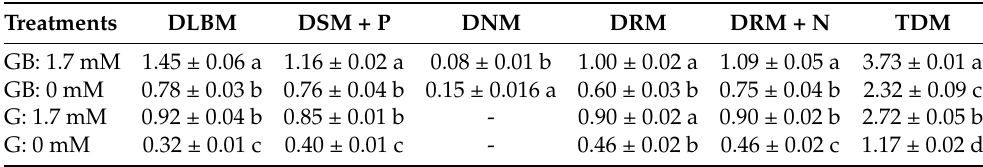
Table 2. Production of dry leaf blade mass (DLBM), stem + petiole (DSM + P), nodule (DNM), root (DRM), root + nodule (DRM + N) and total dry mass (TDM) in g Glycine–Bradyrhizobium and Glycine grown with 1.7 mM NO − and without (0 mM) at 41 days after sowing. Values corresponding to the 3 means ± SE (n =